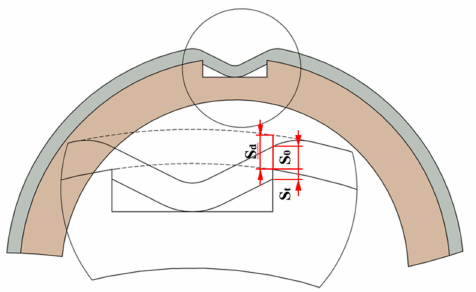
Figure 10. Schematic of the geometric analysis